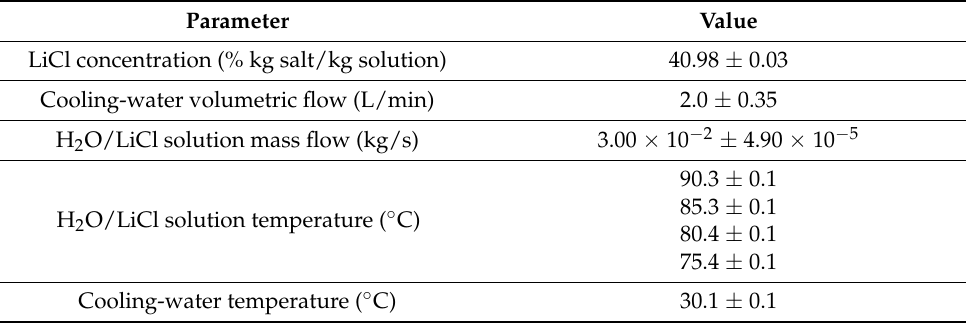
Table 4. Experimental operating conditions in intermittent operation mode.